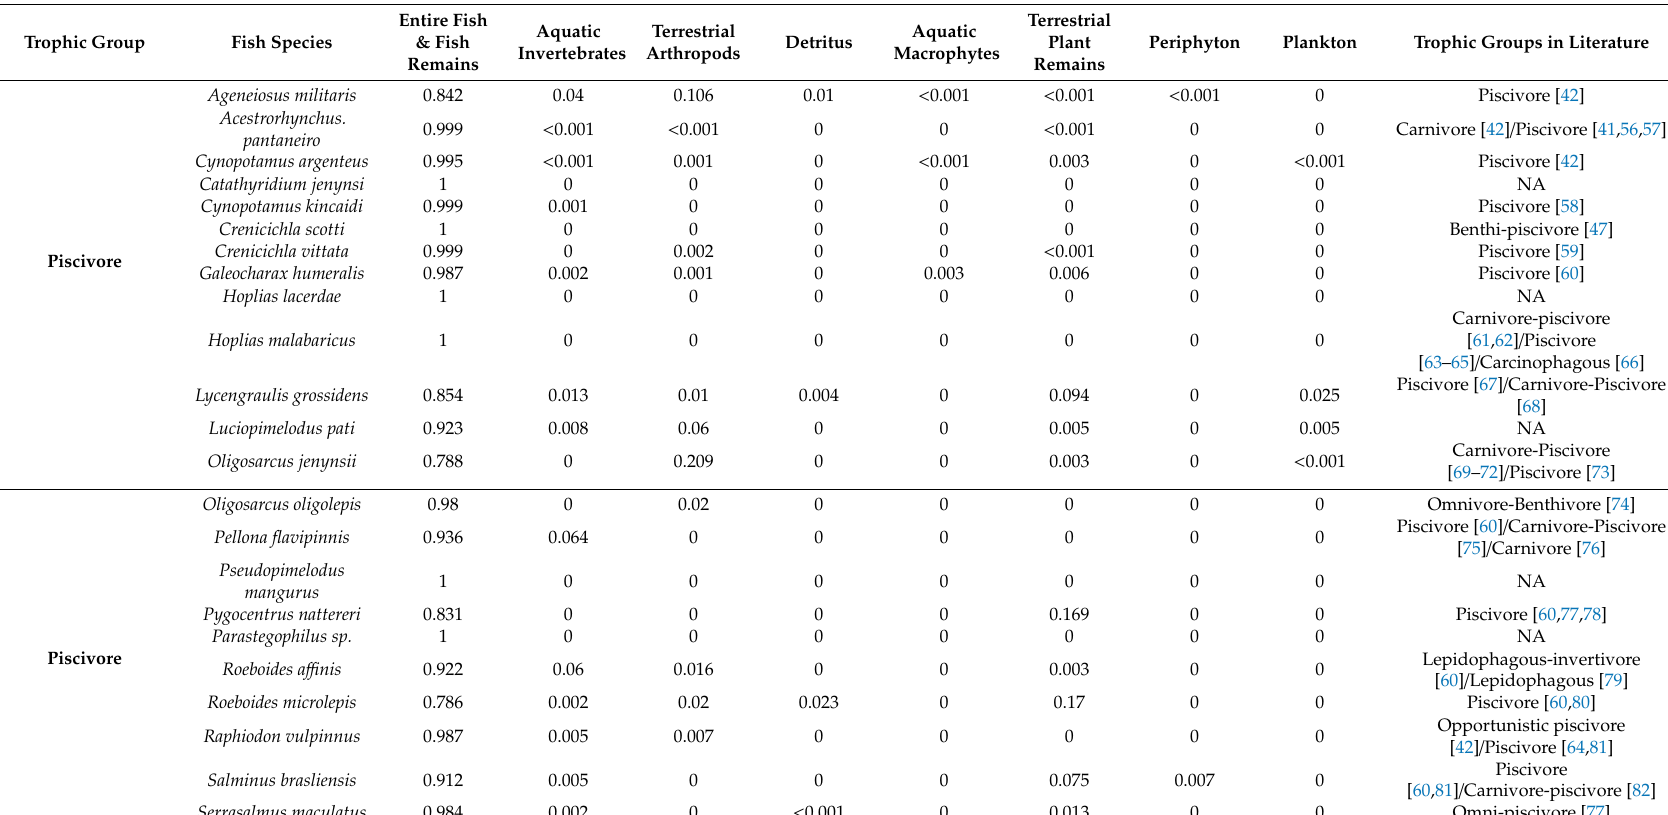
Table 1. Diet and trophic classification of fish species sampled along a longitudinal gradient in Uruguay River. The values for each dietary item type in each species represent the index of relative importance, which combines the frequency of occurrence and the relative volume of each dietary item to describe the diet of a species. For n and size ranges analysed see Table S2. Previous trophic classification of species for other systems surveyed from literature is shown in the last column and in References Table 1. NA = No data available. The species with * have not been grouped due to unique dietary